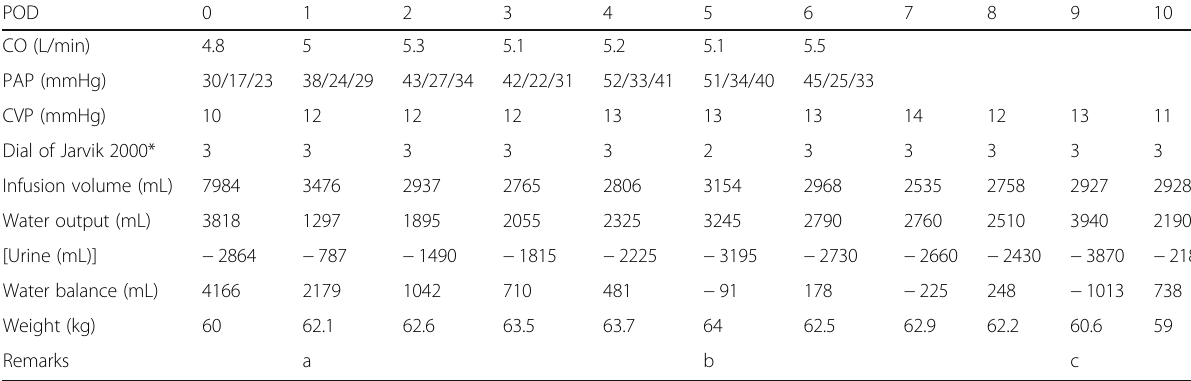
Table 2 Postoperative hemodynamic parameters and water balance